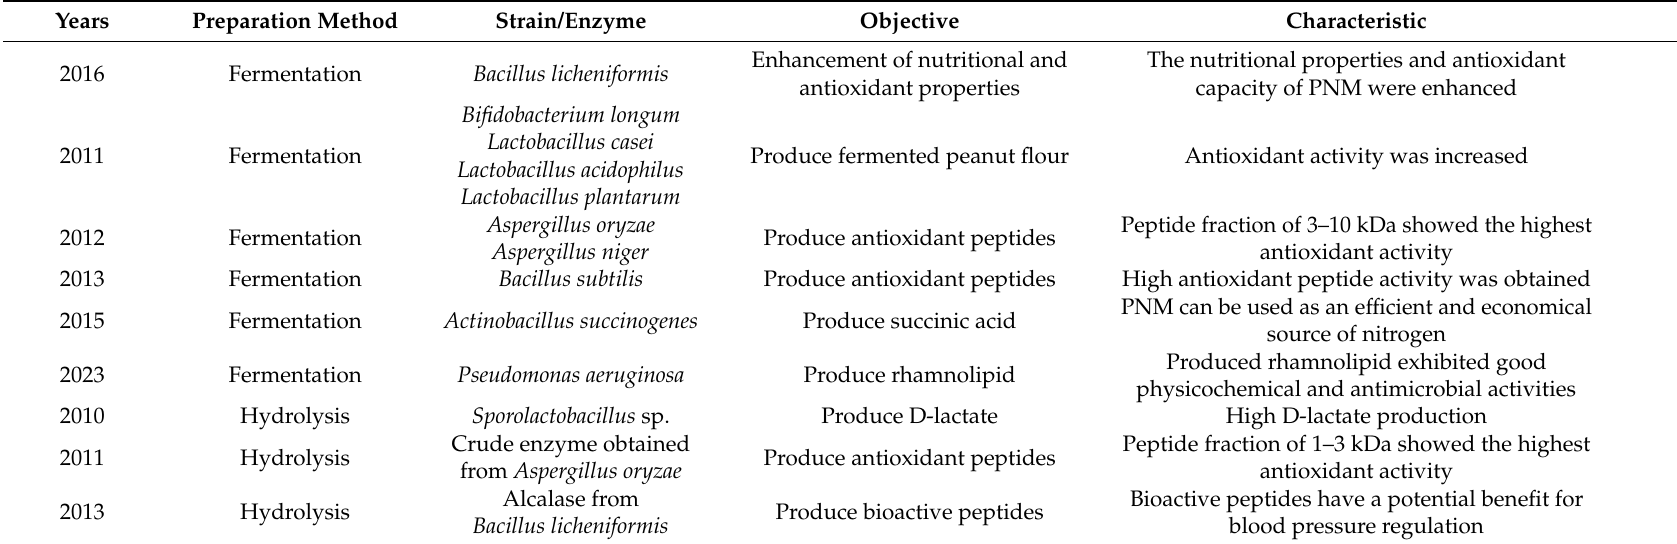
Table 4. Bio-transformation and bio-conversion of